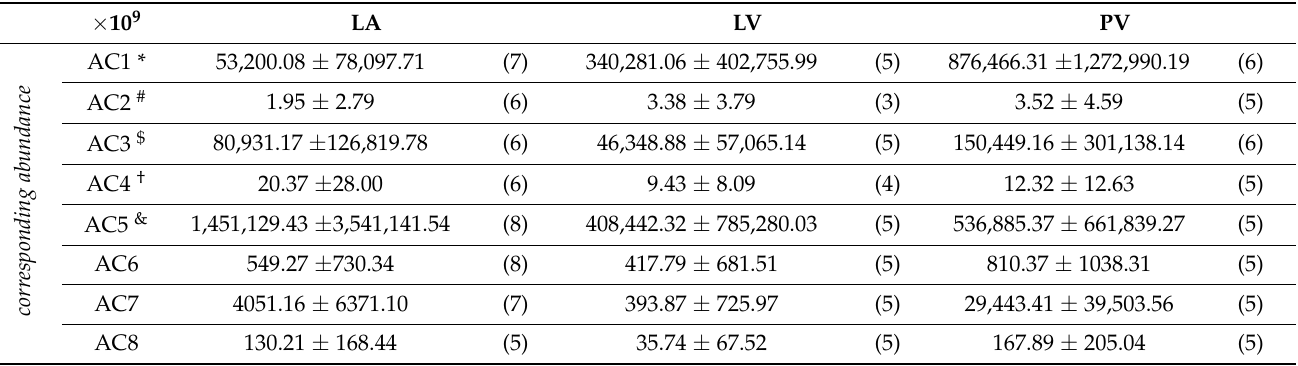
Table 2. Results of simplified-absolute PCR quantification. Statistical p -values for each isotype are given below the table. The number of experiments is provided in